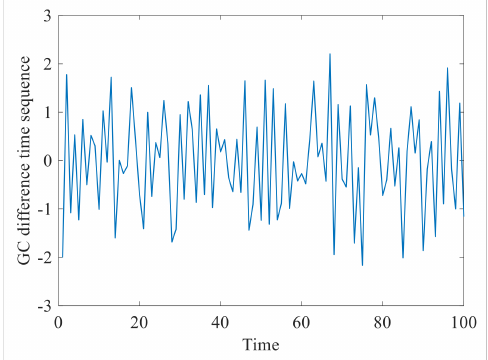
Figure 3. GC difference time